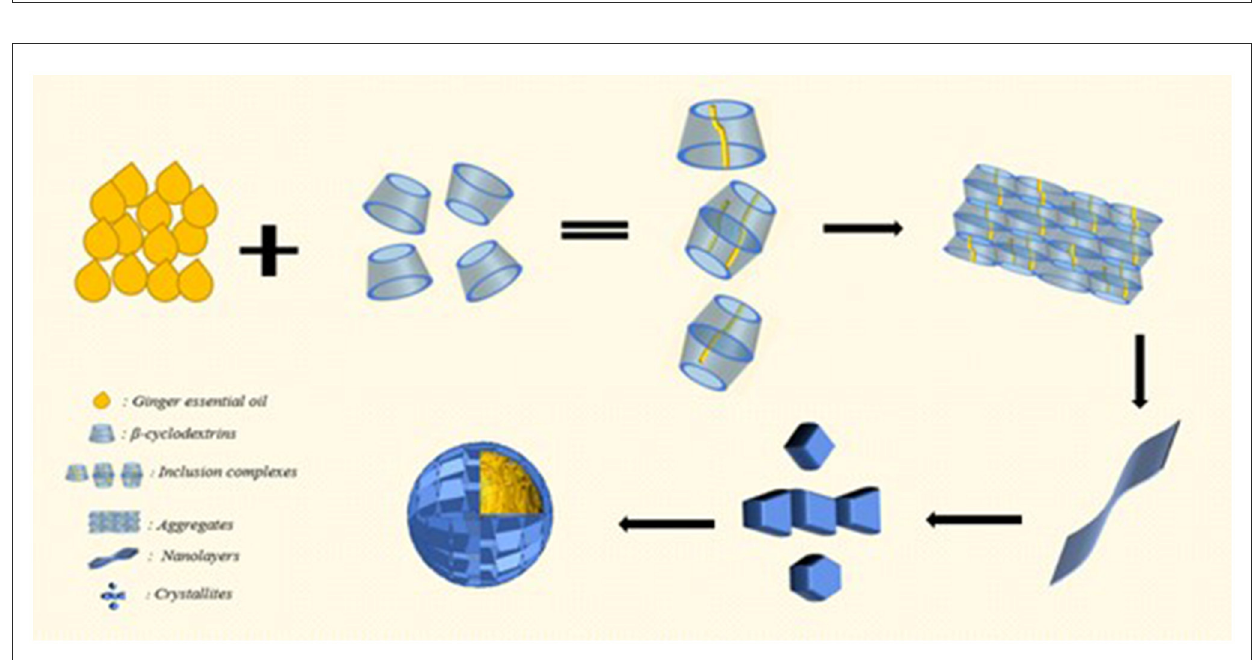
FIGURE6 Schematic diagram of β -CD-stabilized